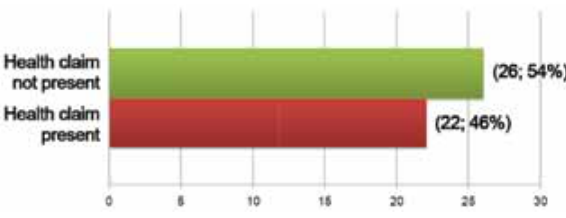
FIGURE 2. MVMs with and without health claim present.